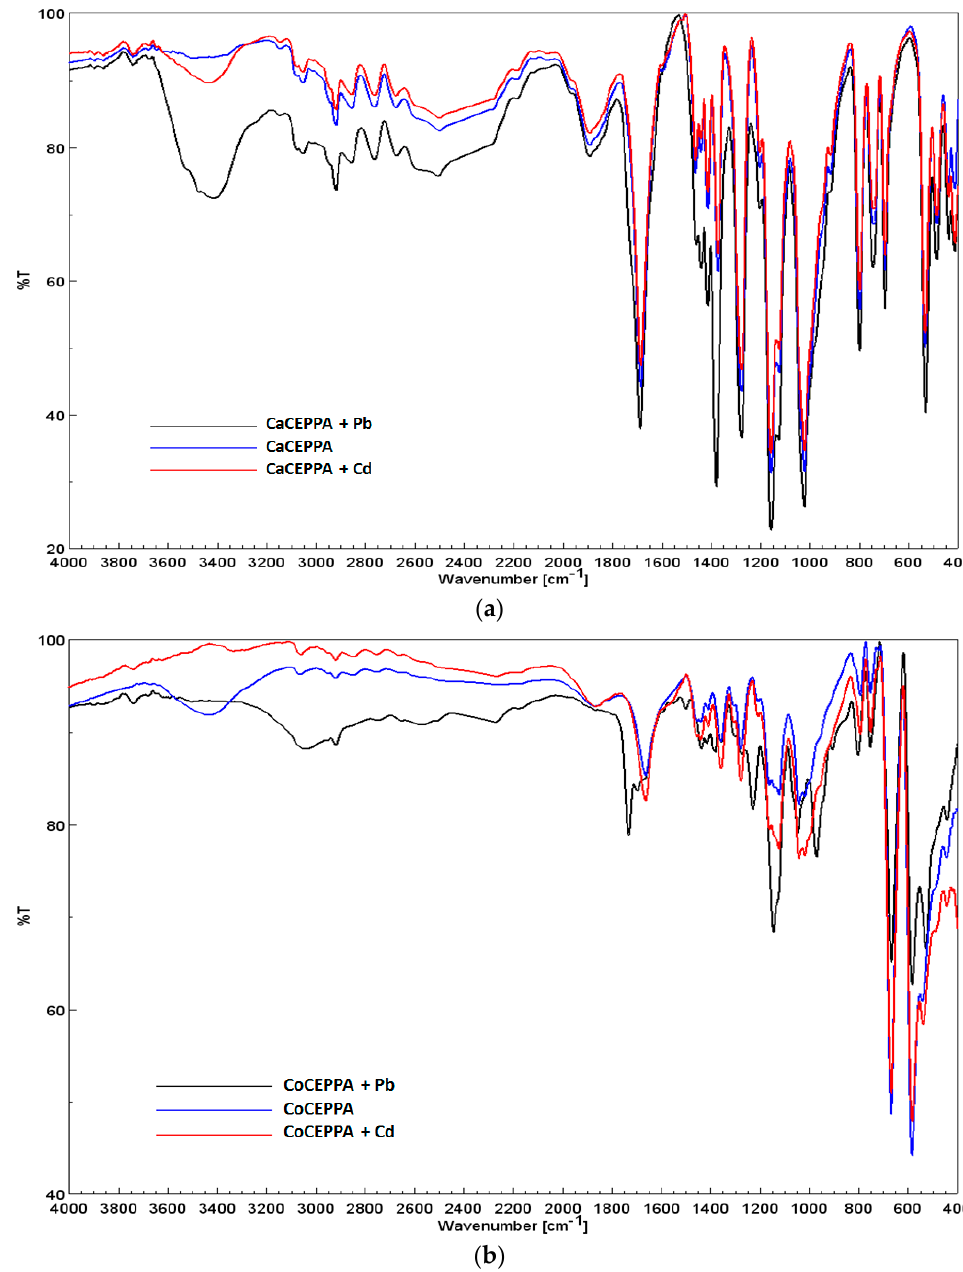
Figure 3. FT-IR spectra of CaCEPPA ( a ) and CoCEPPA ( b ).